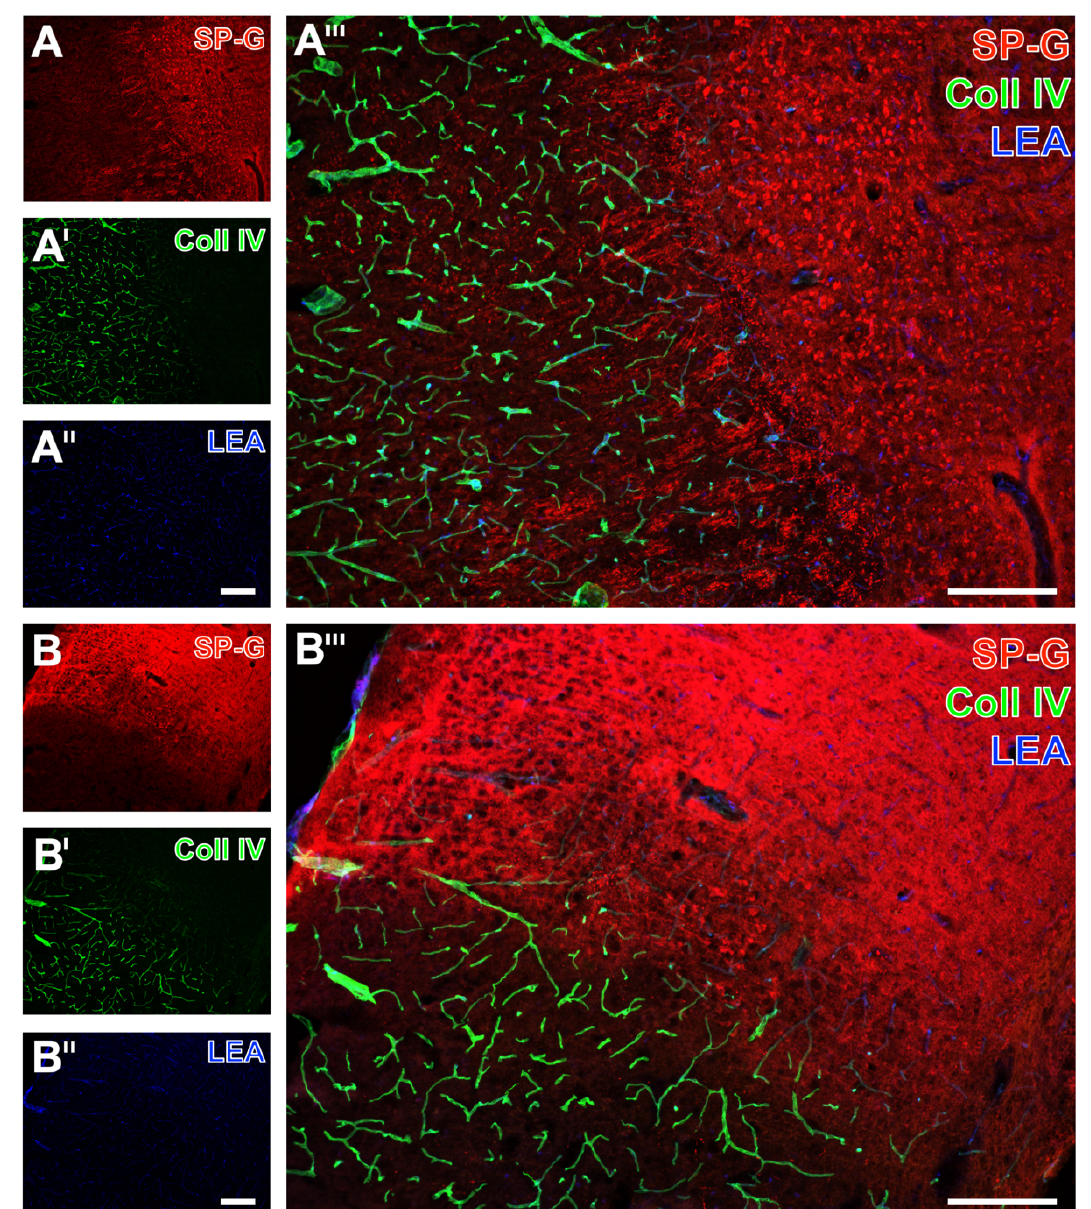
Figure 3. Regional associations of surfactant protein-G (SP-G) and vascular elements after 4 h of ischemia in mice depending on brain regions. Exemplary triple fluorescence labeling of SP-G, collagen IV (Coll IV), and vascular endothelia (LEA) in the affected striatum ( A – A”’ ) and in the neocortex ( B – B”’ ) of mice subjected to 4 h of focal cerebral ischemia. Scale bars: A” (also valid for A and A’ ) = 200 µ m, A”’ = 200 µ m, B” (also valid for B and B’ ) = 200 µ m, B”’ = 200 µ